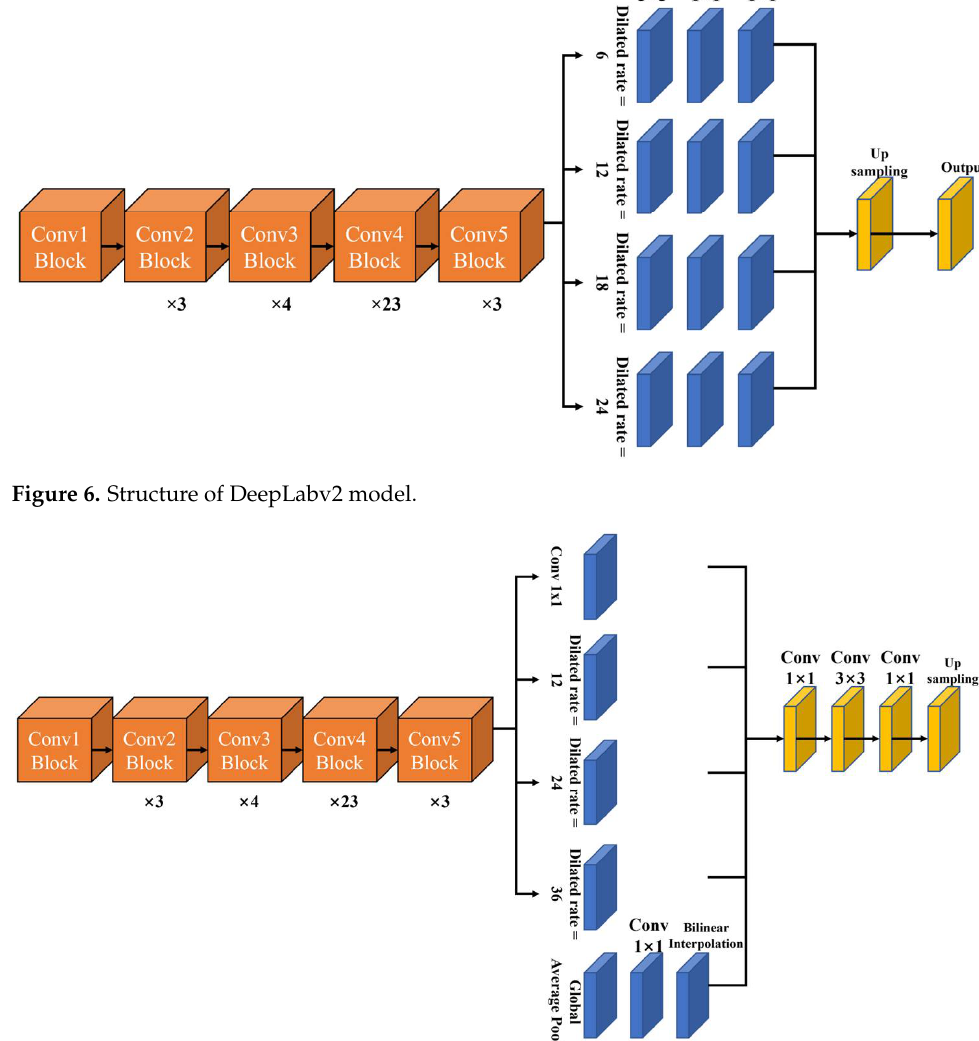
Figure 6. Structure of DeepLabv2 model.